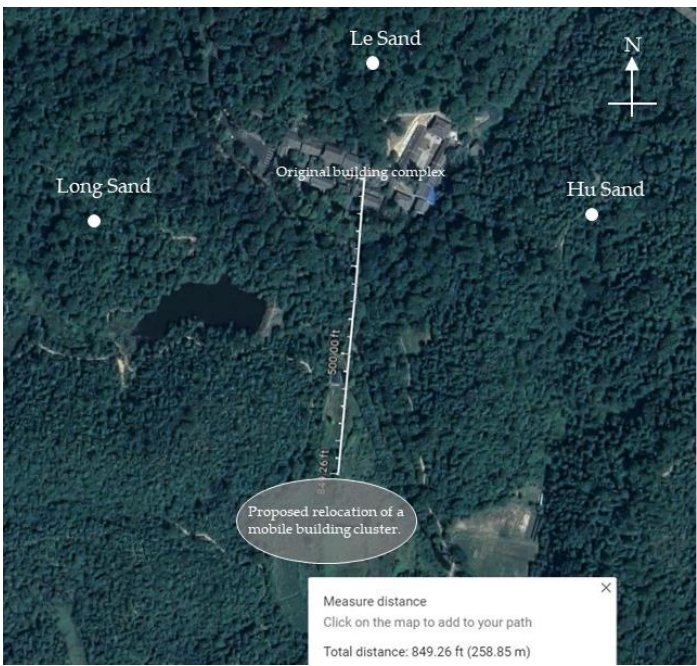
Figure 6. Original Feng Shui building complex and relocated non-Feng Shui building complex location diagram (Source: Google Maps).